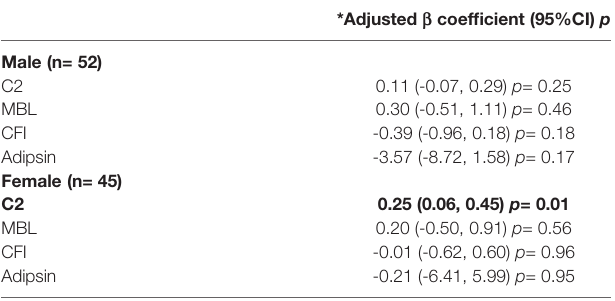
TABLE 3 | Multivariate linear regression model estimates for C5 concentration with synovial fl uid C2, MBL, adipsin, CFI concentration (ng/mL).